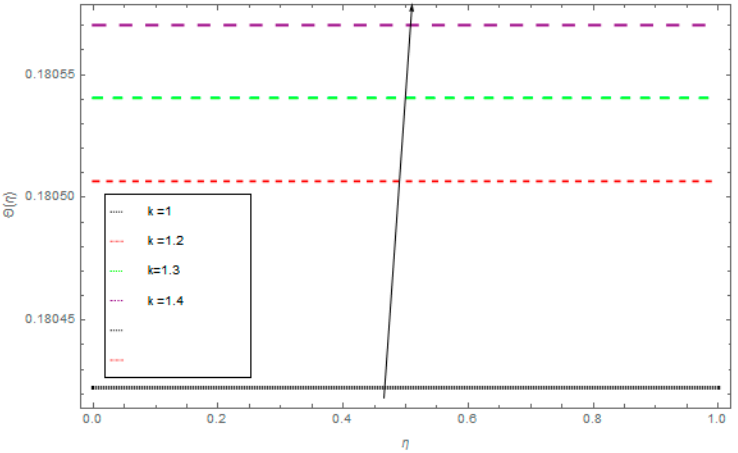
Figure 12. The influence of radiation parameter ( R ) on the Nusselt number.